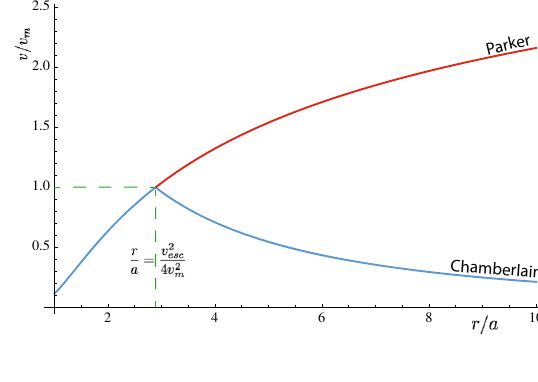
Fig. 5 Comparison of the Parker (1958) and Chamberlain (1960) solar corona